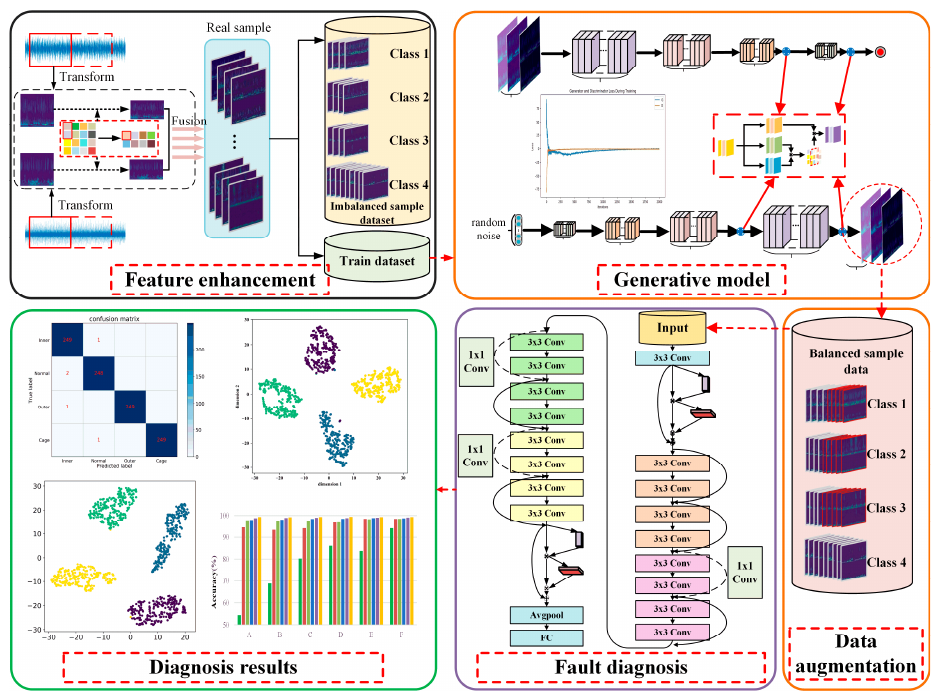
Figure 3. The framework of the proposed diagnosis method with imbalanced data.